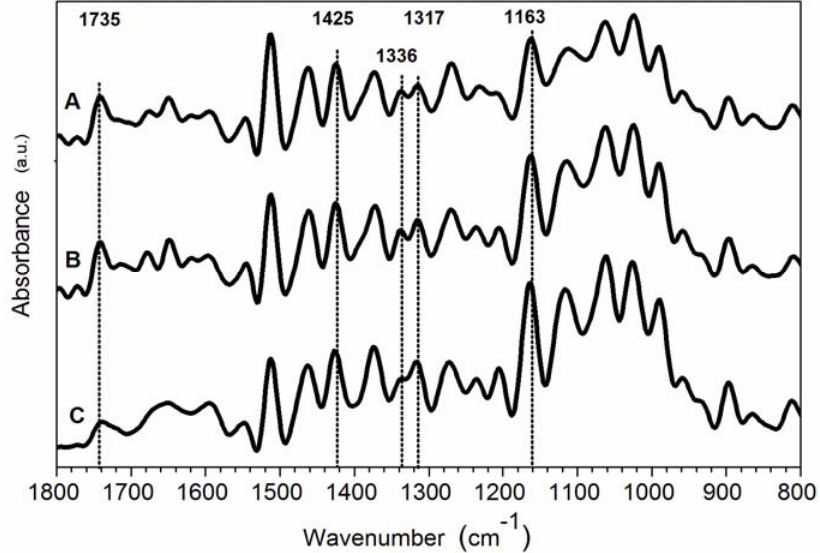
Figure 4. Deconvoluted FT-IR spectra of uncoated wood samples. ( A ) control; ( B ) sample exposed to natural weathering; ( C ) sample artificially weathered.